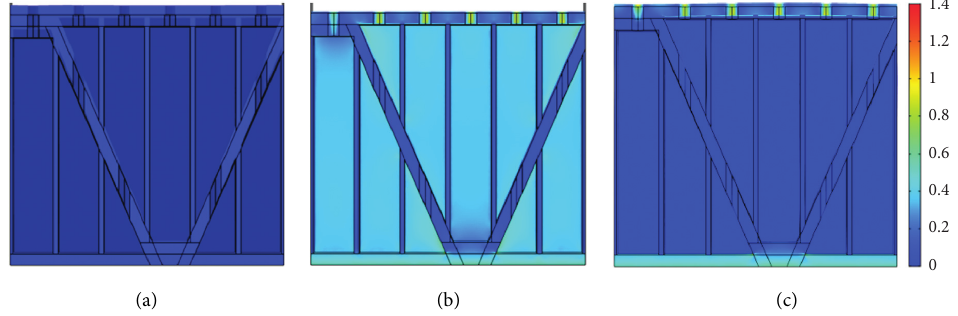
Figure 18: The steady-state stress and deformation distribution after being heated from 300K to